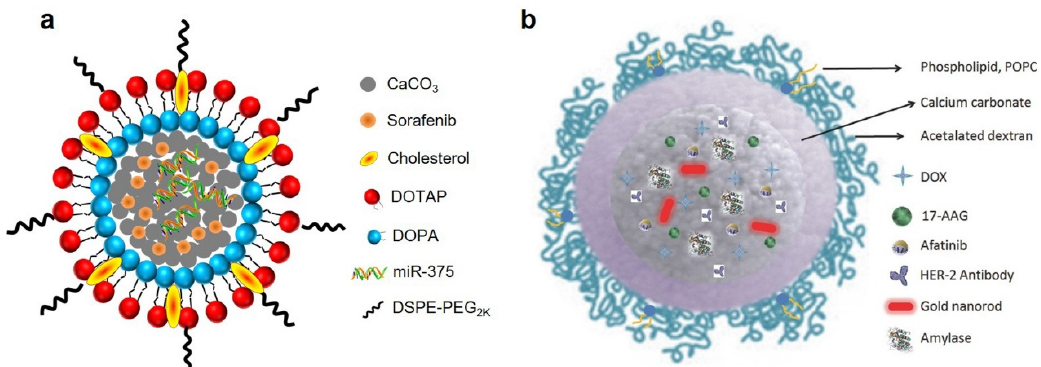
Figure 6. ( a ) Schematic representation of miR-375/Sf-LCC NPs. Reprinted with permission. Copy- right 2018, Elsevier [42]. ( b ) Schematic representation of gold nanorods@CaCO 3 NPs. Reprinted with permission. Copyright 2016, Wiley-VCH [43].